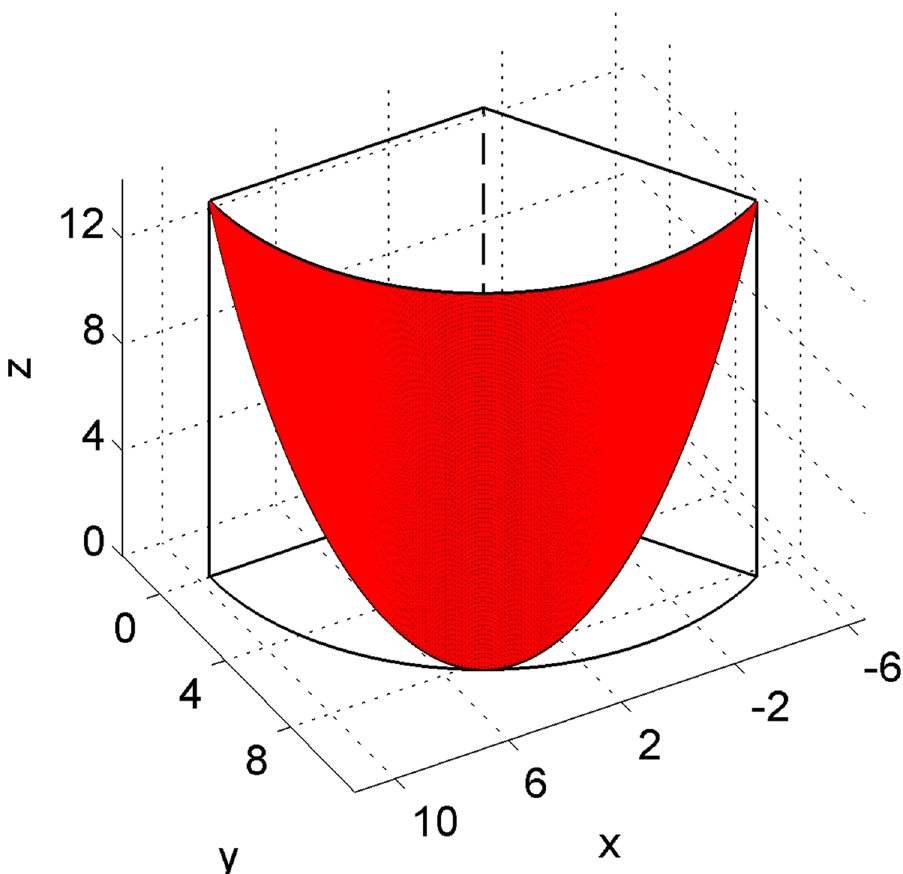
Fig 3. The model for the geometrical shape of a cusp in the pulmonary valve. The leaflets is considered to be one- third of the cylindrical shell.